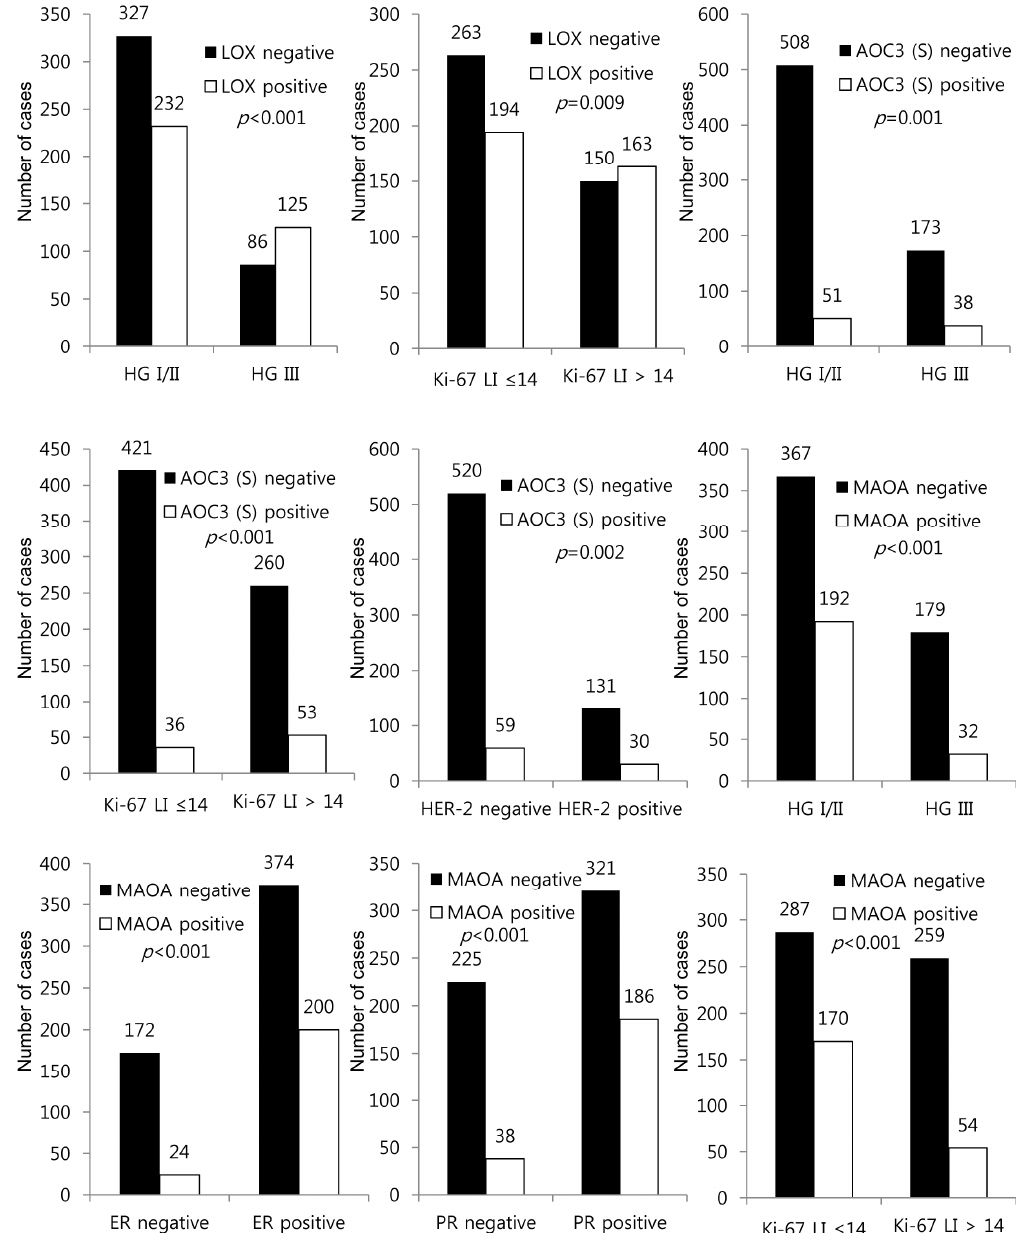
Figure 3. Correlation between the expression of amine oxidase and clinicopathological characteristics. LOX positivity was associated with a high histological grade ( p < 0.001) and high Ki-67 LI ( p = 0.009). Stromal AOC3 positivity was associated with a high histological grade ( p = 0.001), high Ki-67 LI ( p < 0.001), and HER-2 positivity ( p = 0.002). MAO-A positivity was associated with a low histological grade ( p < 0.001), estrogen receptor (ER) positivity ( p < 0.001), PR positivity ( p < 0.001), and low Ki-67 LI ( p < 0.001).